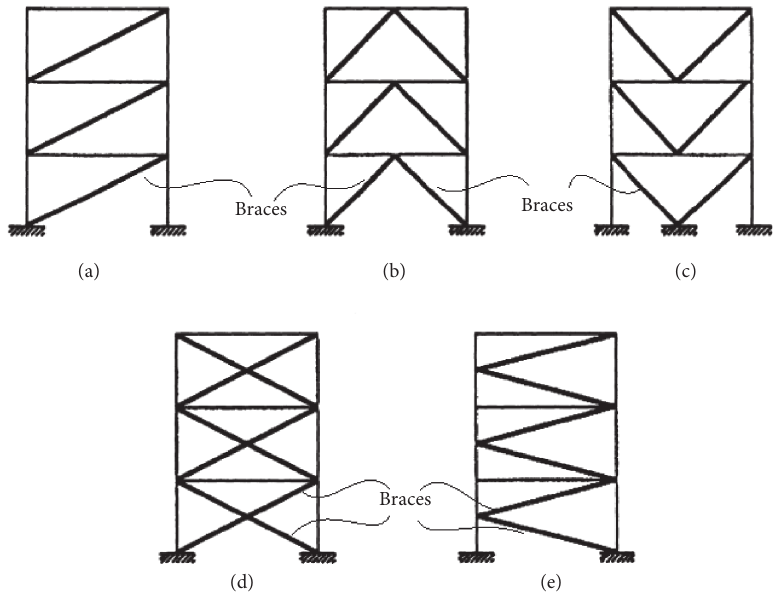
Figure 1: Configuration types of concentric bracing frames [2].